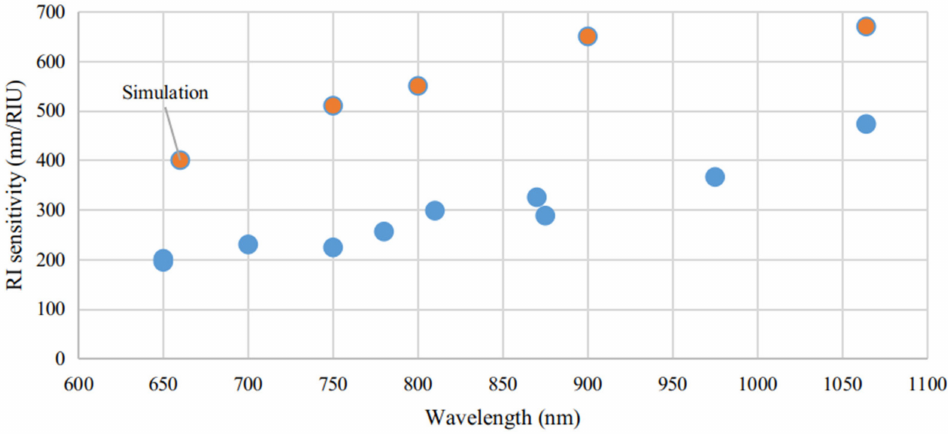
Figure 8. Longitudinal LSPR refractometric sensitivity dependence on aspect ratio for Au NRs. The orange data points are from numerical simulations, whereas the blue data points were experimentally